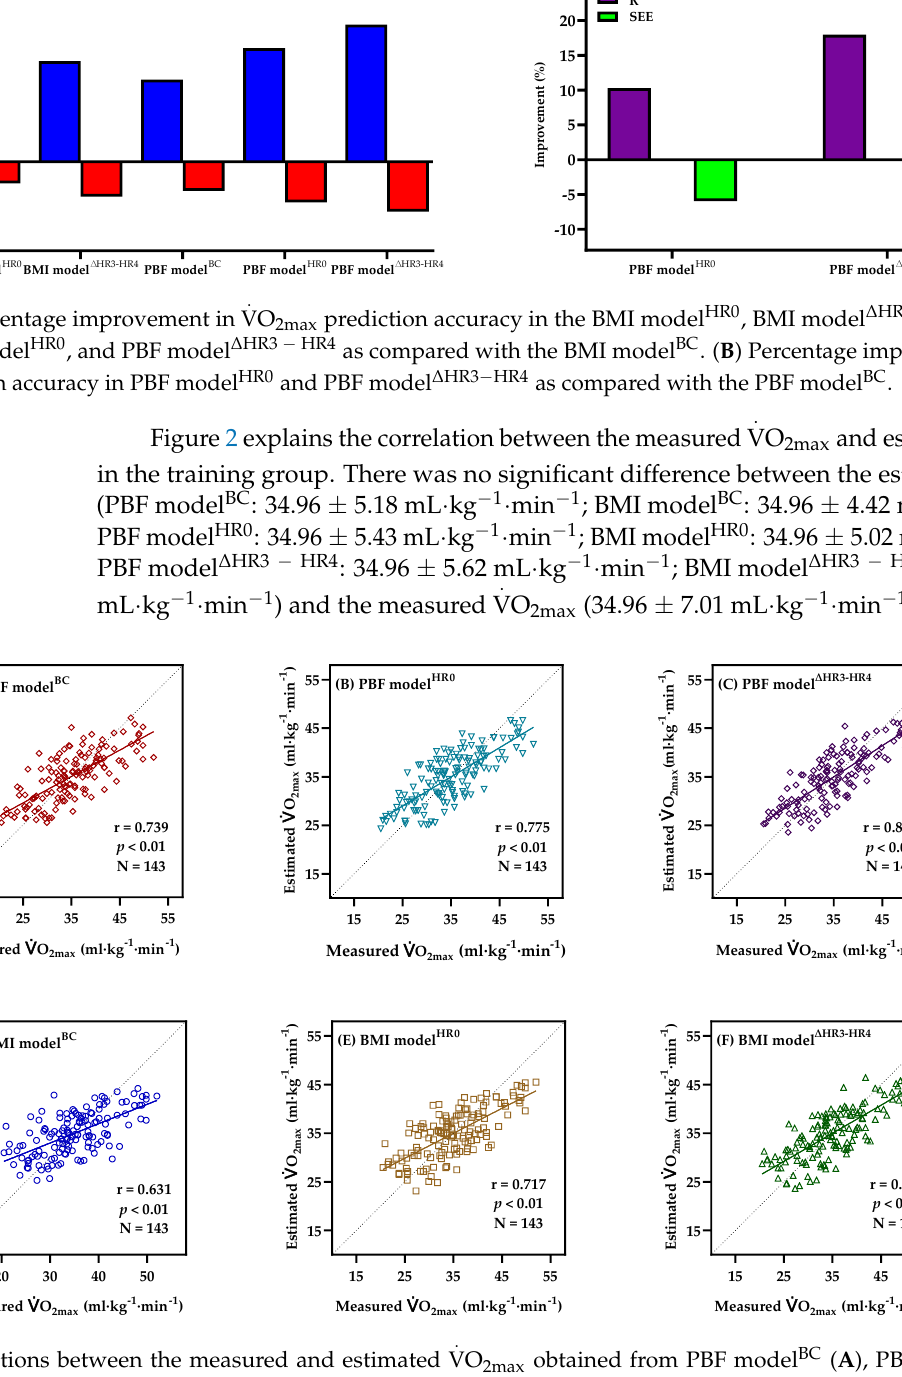
Figure 2. Correlations between the measured and estimated V ( B ), PBF model ∆ HR3 − HR4 ( C ), BMI model BC ( D ), BMI model HR0 ( E ), BMI model ∆ HR3 − HR4 ( F ), in the training group, showing the regression line and Pearson’s correlation coefficient.